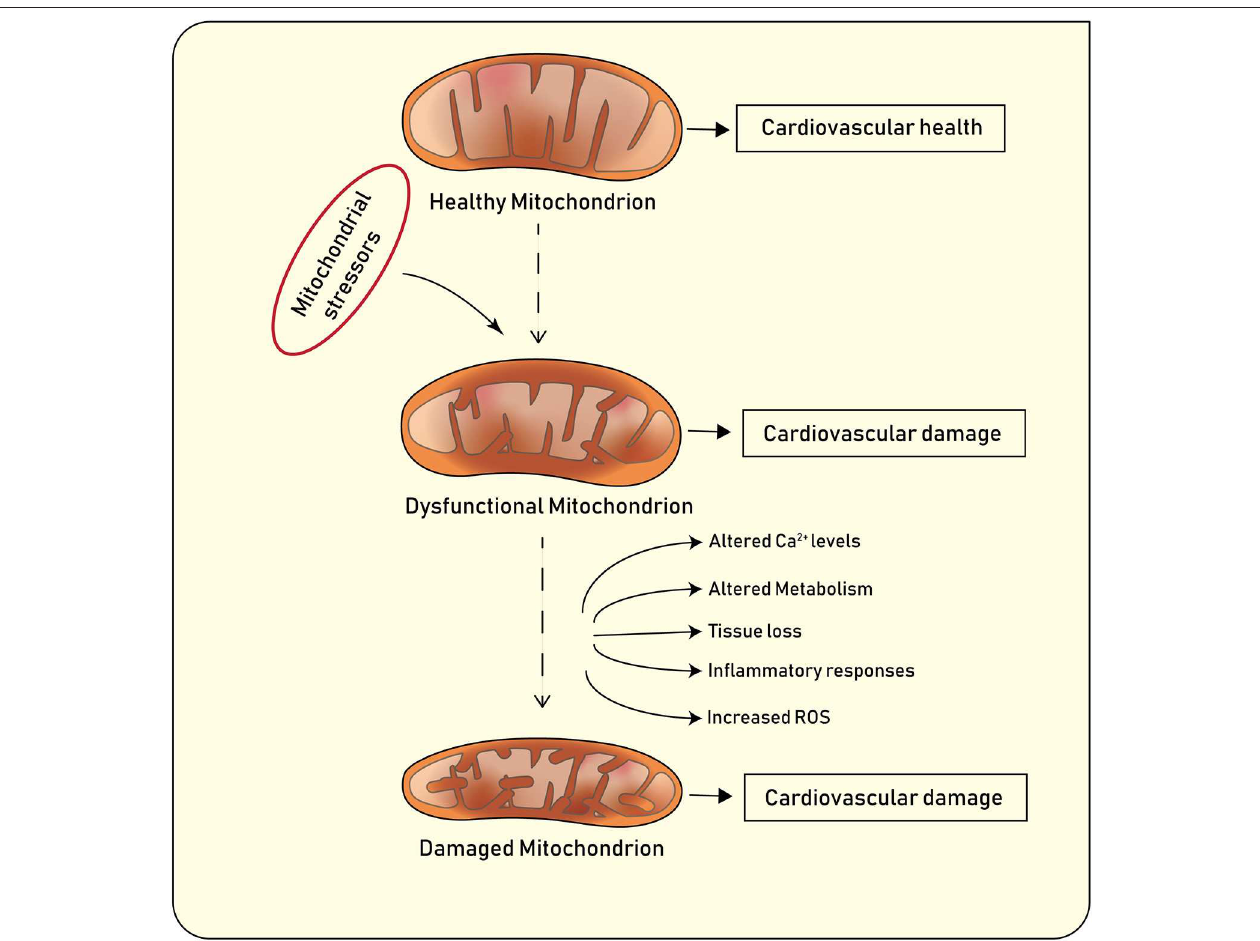
FIGURE 1 | Main features of healthy and diseased mitochondria, and implications for cardiovascular